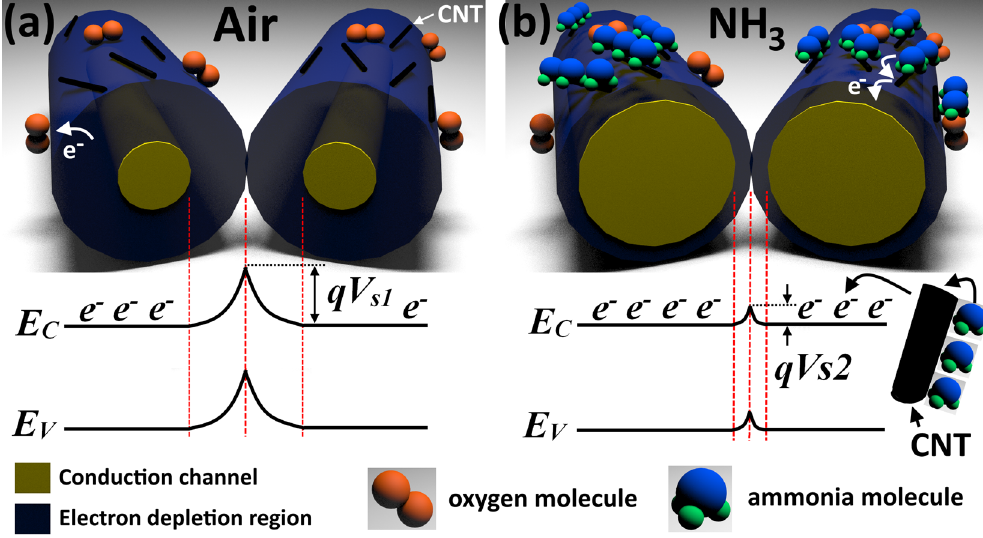
Figure 4. Proposed gas sensing mechanism with energy band diagrams to NH 3 at room temperature for ZnO- CNT networks without taking in account the oxidation of NH 3 molecules by oxygen species. ( a ) At exposure to air the oxygen molecules are adsorbed on the surface of ZnO NWs forming an electron depletion region (by ionization) and pottential barrier at the interface of NWs with height qV s1 . ( b ) Under exposure to ammonia, the NH 3 molecules are adsorbed on the CNT surface and transfer the donated electrons to the ZnO NWs. This leads to a narrowing of the electron depletion region and lowering of the potential barrier height qV s2